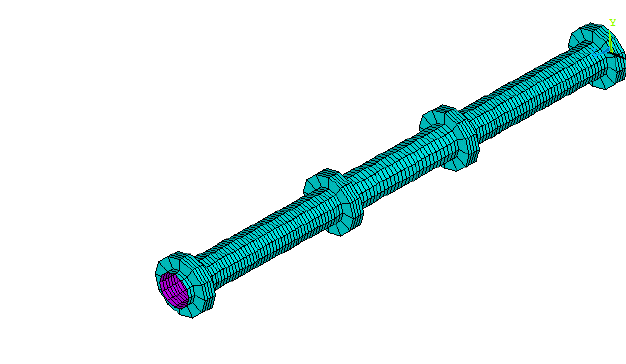
Figure 10. The first group of specimens of parametric case studies.